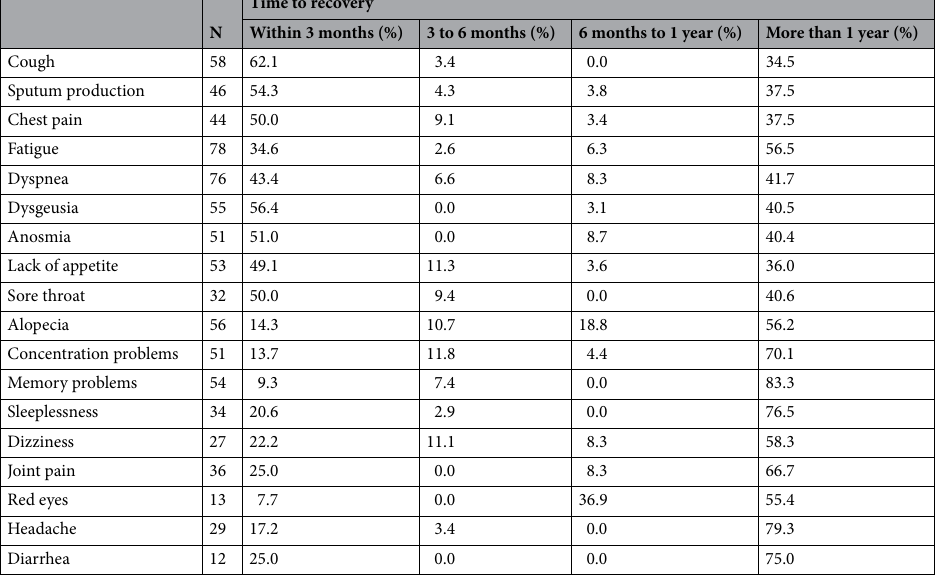
Table 5. Time to recovery of each symptom in Severe Group.